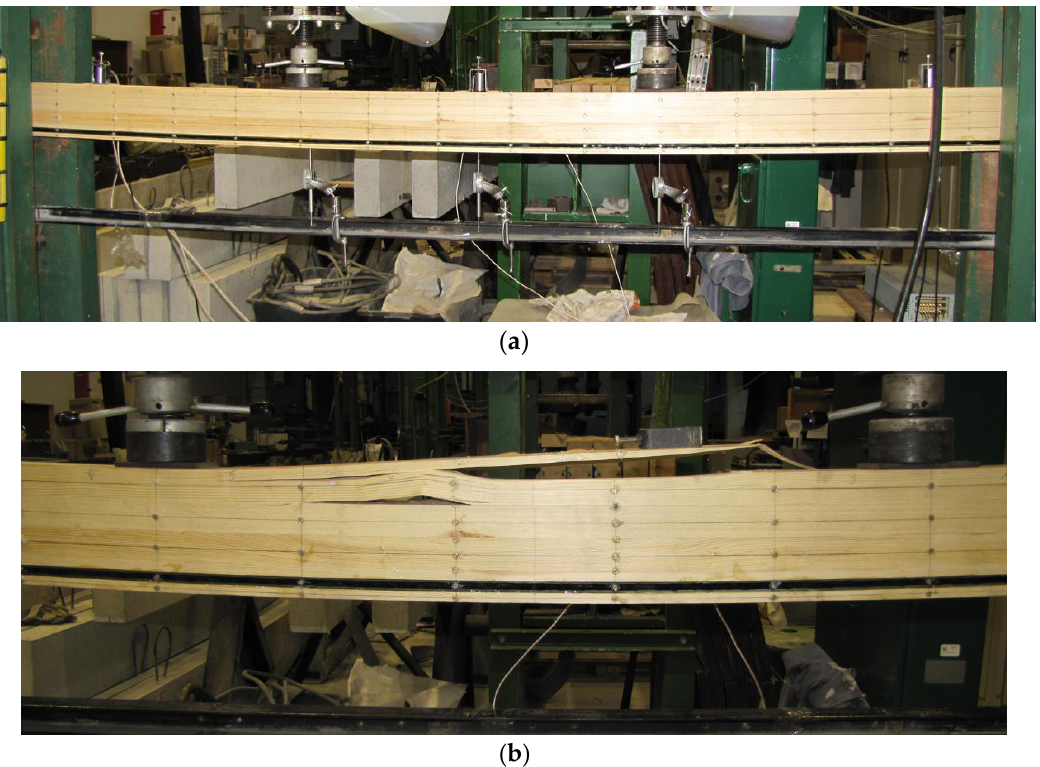
Figure 4. The test set-up of timber beams with BFRP bars: ( a ) strengthened timber beam during loading; ( b ) strengthened timber beam after failure.